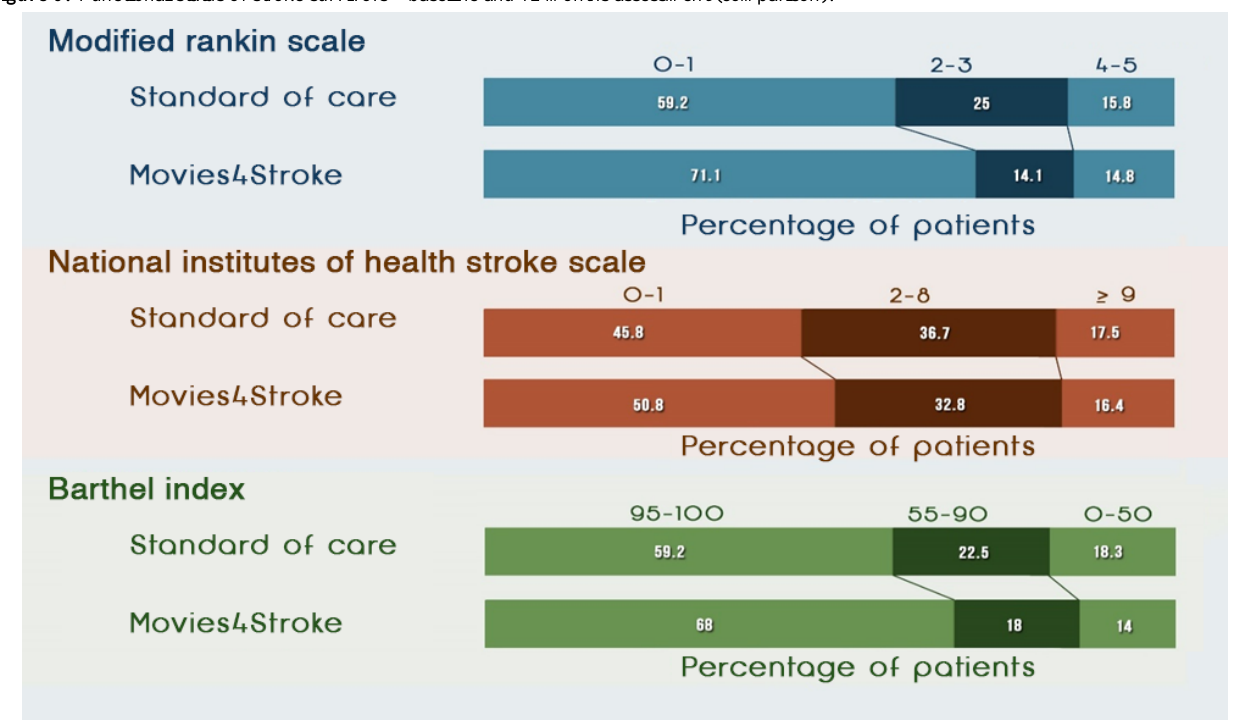
Figure 6. Functional status of stroke survivors—baseline and 12 months assessment